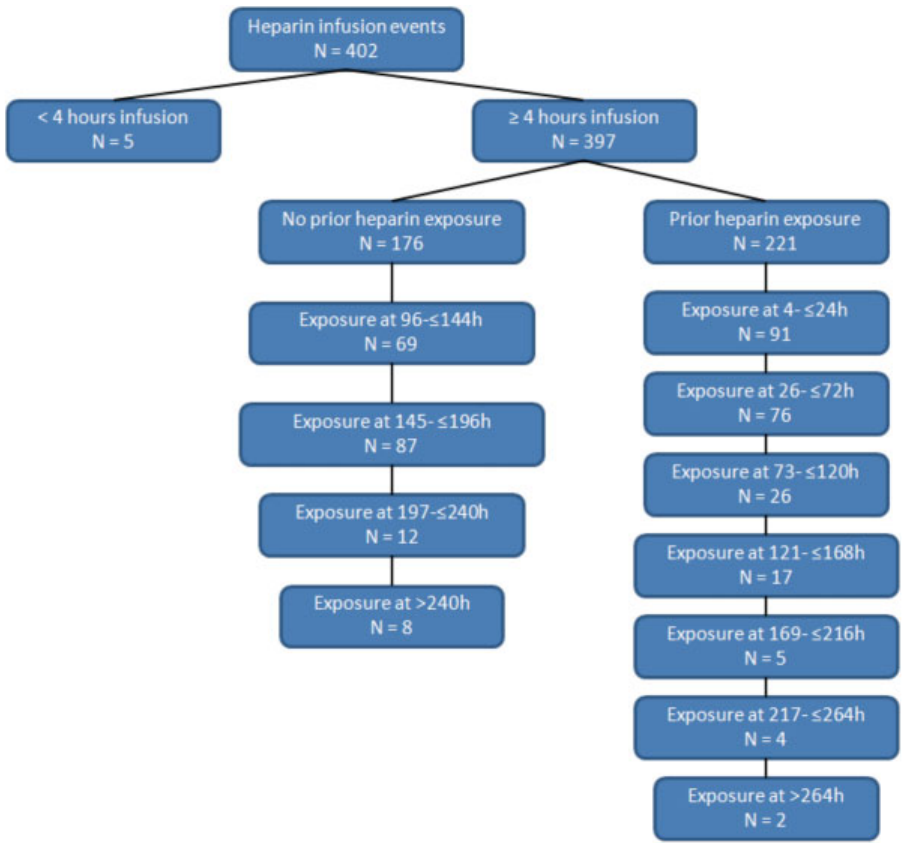
Fig. 2 Number of heparin infusion events, including duration and number of re-exposure